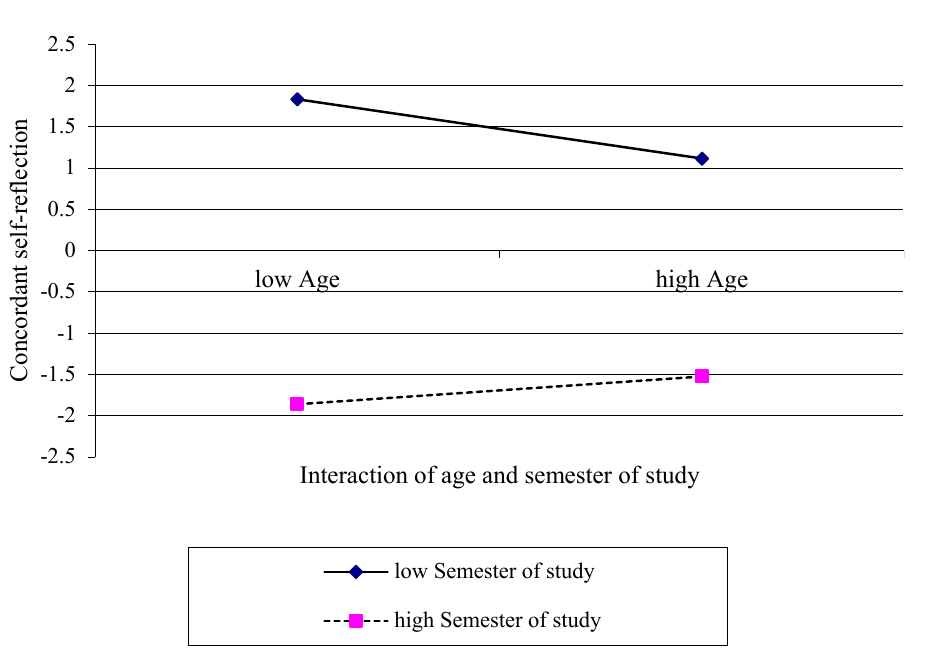
Figure 5. Interaction effect of age and semester of study on the concordant self-reflection in the physical examination course concept illustrated as simple slopes.